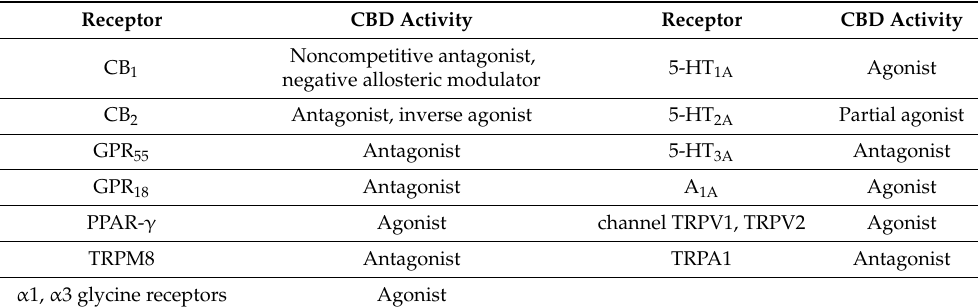
Table 1. Postulated effects of cannabidiol (CBD) on the receptors [52,54,55]. Abbrev.: A—adenosine, TRPA1—transient receptor potential ankyrin 1, TRPV—transient potential vanilloid receptor, CB— cannabinoid, GPR—G protein-coupled receptor, and PPAR—peroxisome proliferator-activated recep- tor, 5-HT – serotonin receptor, TRPM – transient receptor potential